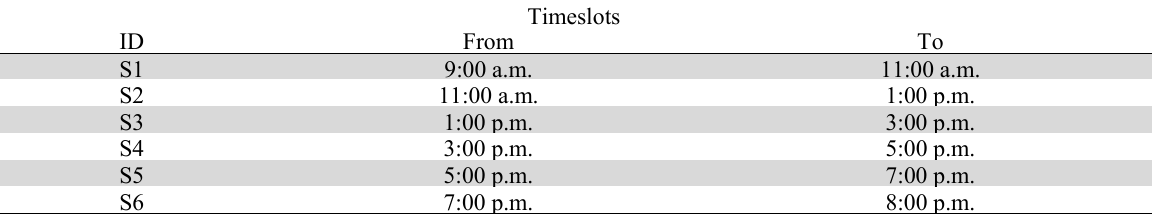
Defined timeslots